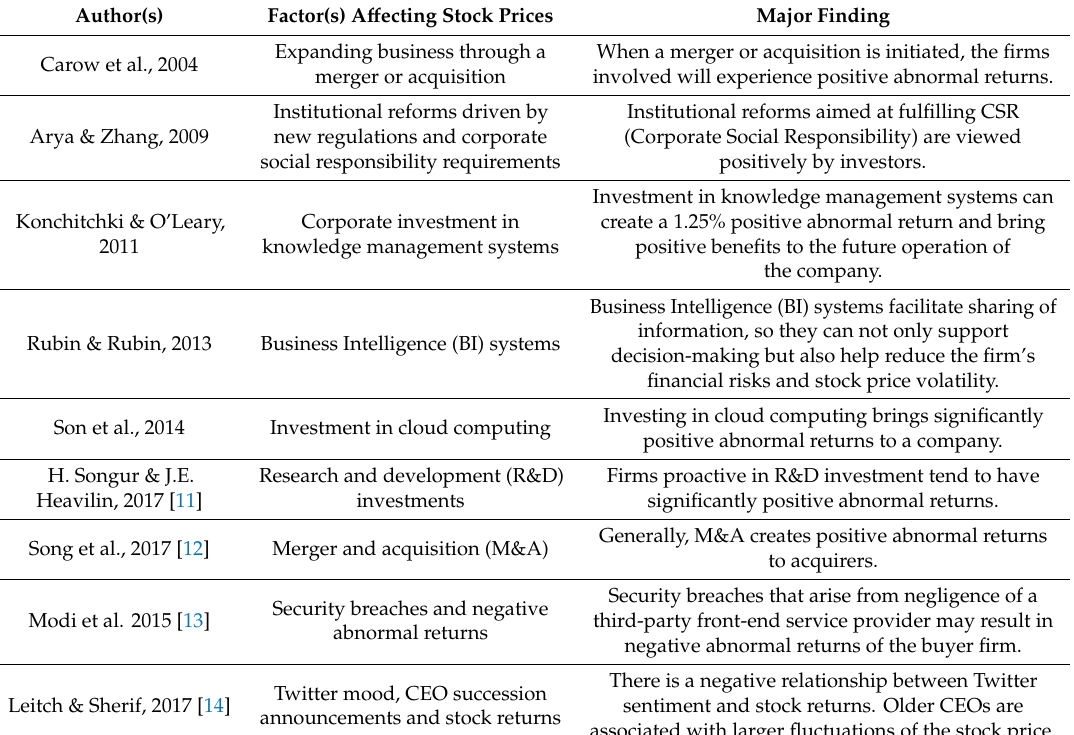
Table 1. Prior studies on factors a ff ecting stock